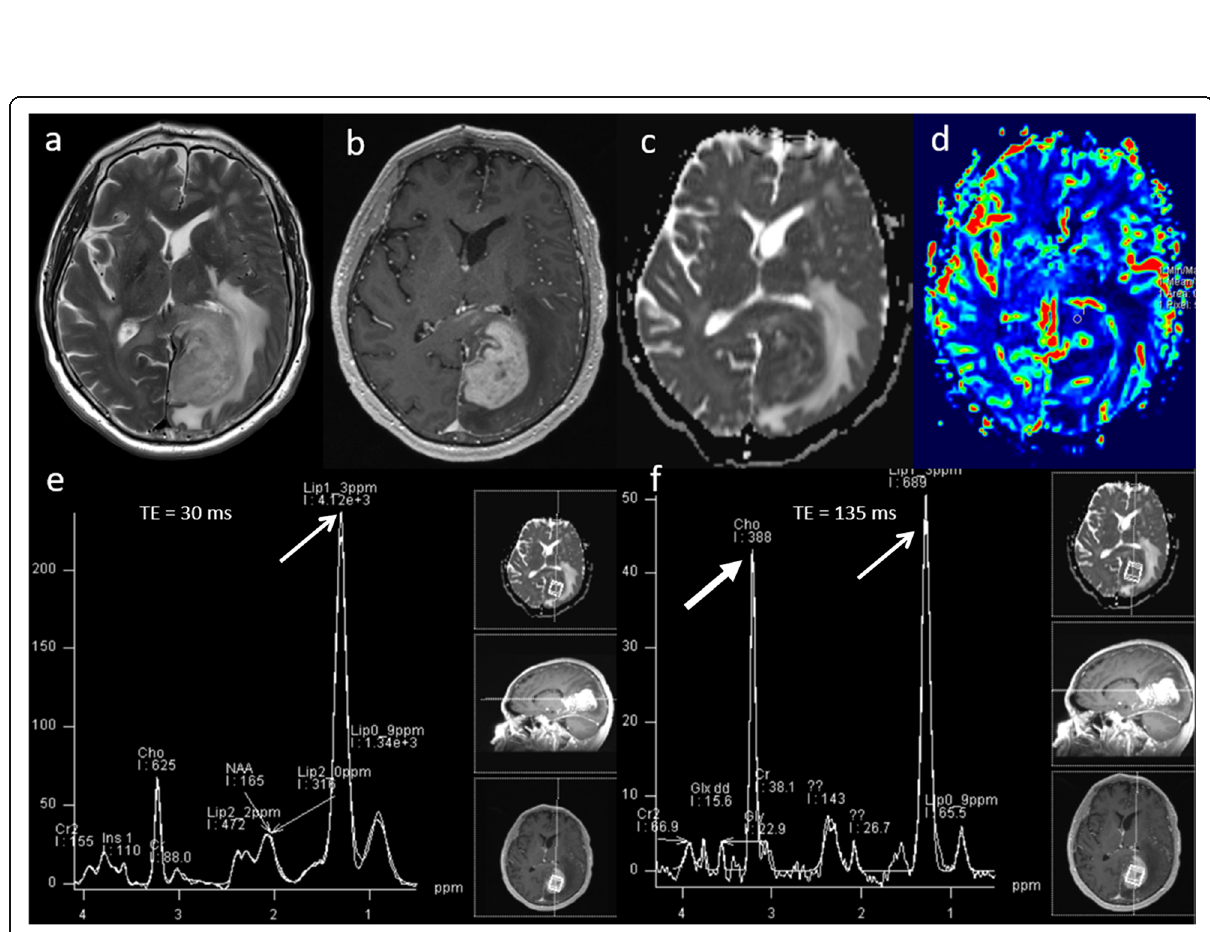
Fig. 2 Lymphoma. Conventional MRI Findings: a , b Axial T2W and post-contrast T1W sequences show a large homogenously enhancing lesion in the left occipital lobe. c ADC map shows very low ADC (< 600 × 10 − 6 mm 2 s − 1 ) throughout the lesion. d PWI shows low perfusion throughout the lesion compared to normal-appearing contralateral white matter. e , f MRS shows very high Cho/Cr ratio (> 6, thick arrow) and very high lipid peaks in a non-necrotic appearing lesion (TE 30 ms and 135 ms, thin arrows). The low perfusion, very low ADC, very high lipid peak in a non- necrotic appearing lesion and high choline peak are characteristic of lymphoma. Histopathology confirmed a diffuse large B cell